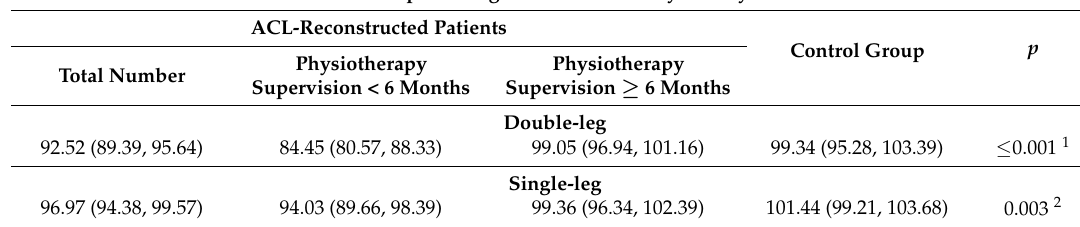
Table 5. Between-group comparison of vertical ground reaction force limb symmetry index values obtained during double-leg and single-leg vertical hop landing in patients with postoperative physiotherapy supervision < 6 months, patients with postoperative physiotherapy supervision ≥ 6 months, and the control group; ACL: anterior cruciate ligament; p : level of significance of the between-group difference; vGRF BM: vertical ground reaction force normalized to body mass. Values expressed as the arithmetic mean and 95% confidence